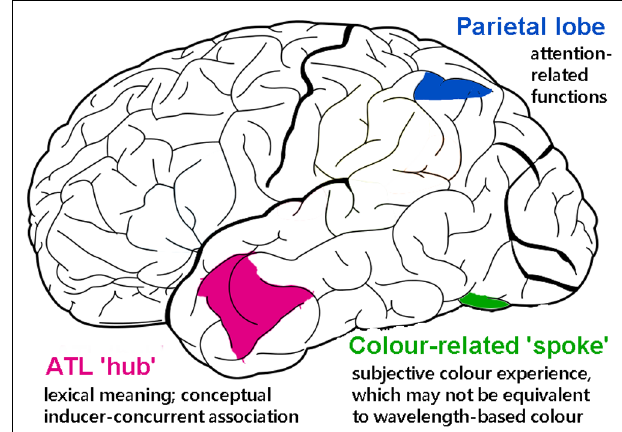
FIGURE 4 |The outer cortical surface with proposed regions involved in the neural substrates of grapheme–color synesthesia under the conceptual-mediation model. The anterior temporal lobe (ATL) is indicated in magenta. In our model, the ATL functions as a representational “hub” that processes lexical meaning and associates the lexicon to synesthetic color representation at an abstract, conceptual level.The color-related area of the posterior ventral temporal cortex is indicated in green.This cortical region contains the fusiform gyrus (V4) and the lingual gyrus. In our model, this area serves as a “spoke” that processes the subjective experience of synesthetic color and may not overlap with the neural basis of real color experience.The posterior parietal lobe is indicated in blue.This region mediates the attention-related functions in synesthesia, such as directing voluntary attention to an inducer or binding graphemes with color at a perceptual level, akin to its role in the typical function of binding various visual attributes (color, shape, location, etc.) of an